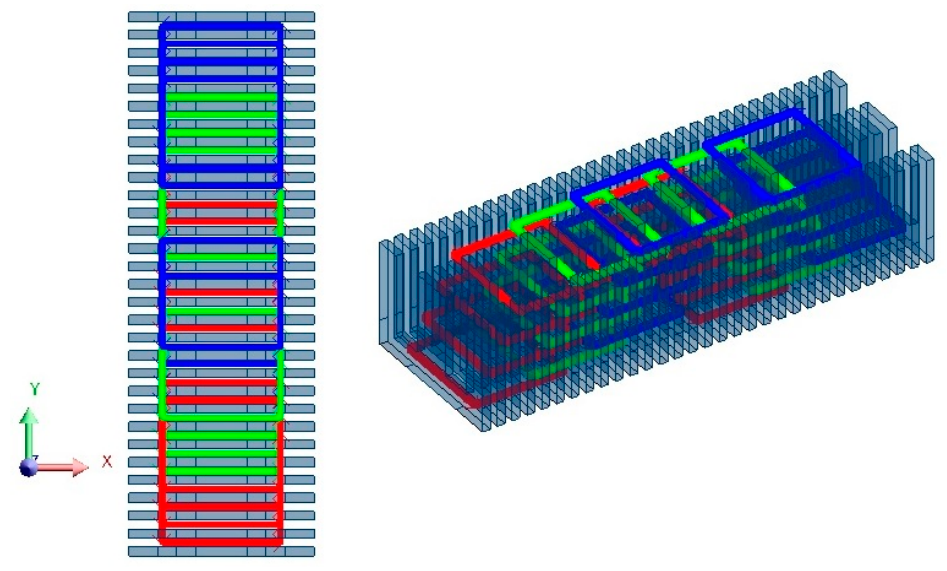
Figure 4. Scheme of the AC three-phase winding with four layers.